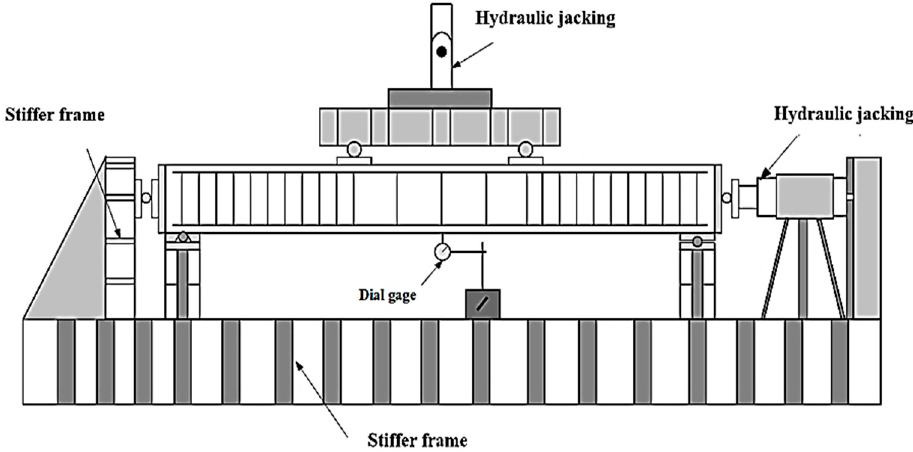
Figure 4. Sketch of modified testing machine.